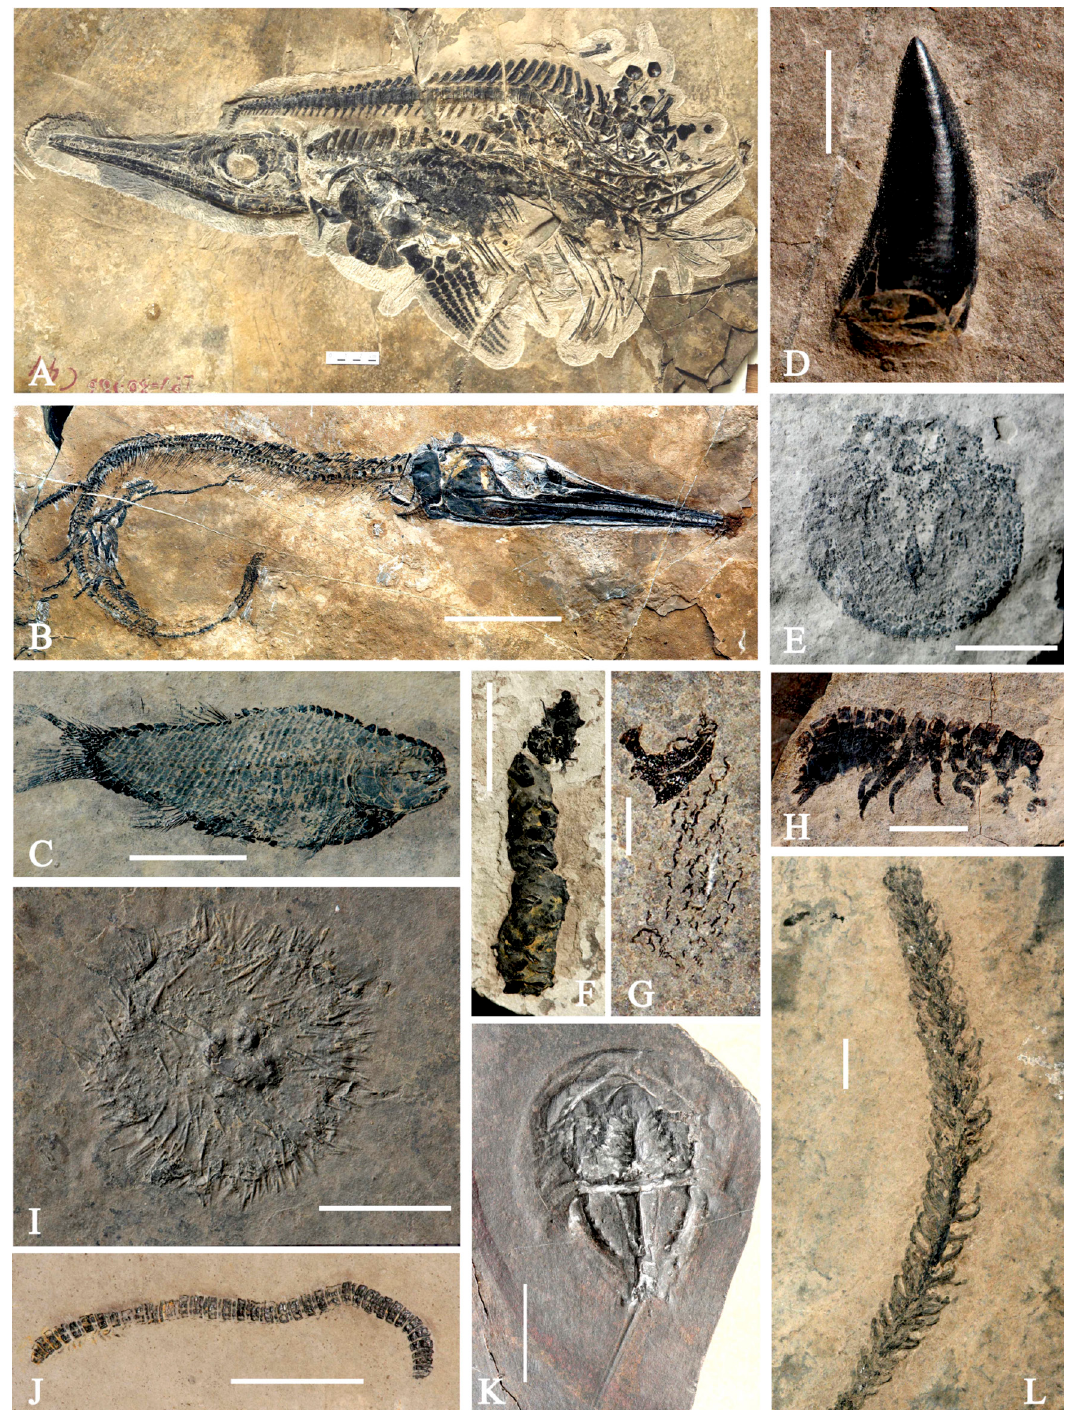
Figure 6. Typical fossils of the Luoping biota. A) Ichthyosaur (LPV 30986); B) carnivorous fish Saurichthys yunnanensis (LPV 20881); C) eugnathid fish (LPV 11846); D) tooth of archosaur (LPV 31411); note serrated margin; E) cycloid arthropod (LPI 32637); F) coprolite containing fish scales (LPI 61753); G) belemnoid with preserved arm hooks (bottom) and beak parts (top) (LPI 61543); H) Protamphisopus baii , an isopod arthropod (LPI 61713); I) sea urchin (LPI 61701); J) Sinosoma lupingense , a millipede (LPI 61593); K) Yunnanolimulus luopingensis , a xiphosurid arthropod (LPI 61299); L) conifer plant (LPI 60148). Scales bars, (A) 4 cm, (B) 5 cm, (G) 2 mm, (C, I–L) 1 cm, (D–F, H, J) 0.5 cm, respectively. All specimens are deposited at the Chengdu Center of China Geological Survey (LPI = Luoping invertebrates; LPV = Luoping 269